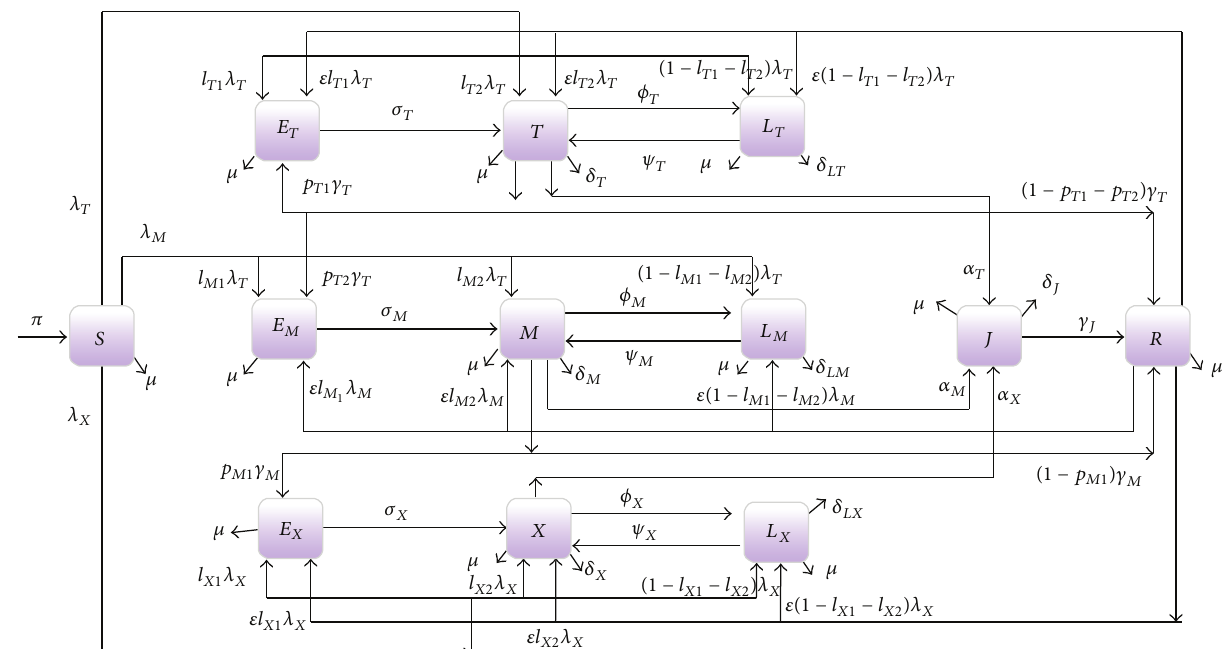
Figure 1: Systematic flow diagram of the tuberculosis model